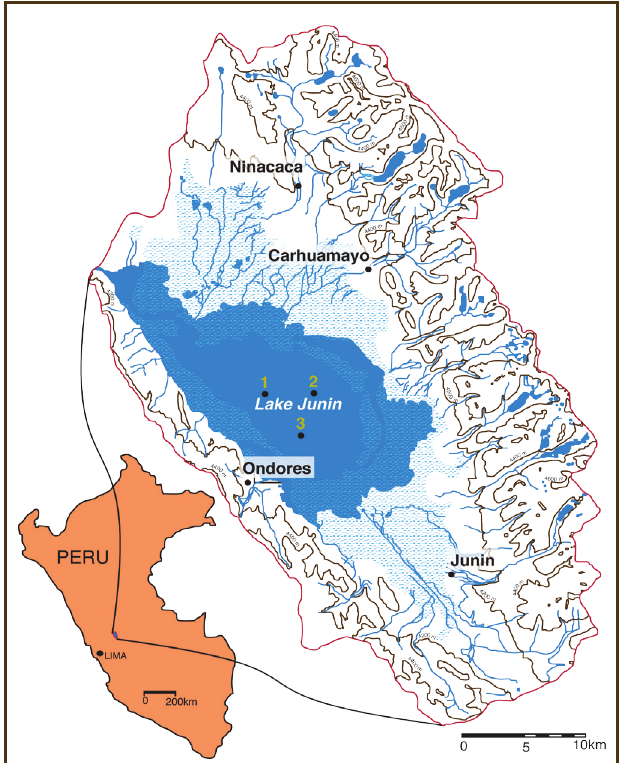
Figure 1. The Lake Junin basin with proposed coring localities 1–3 (Table 1). The eastern cordillera is extensively glaciated, and paleoglaciers reached the eastern edge of the lake on multiple occasions over the past several hundred thousand years. Relatively high rates of glacigenic sedimentation are expected during intervals of expanded ice cover at proposed core sites 1 and 2, whereas site 3 should contain the highest concentration of